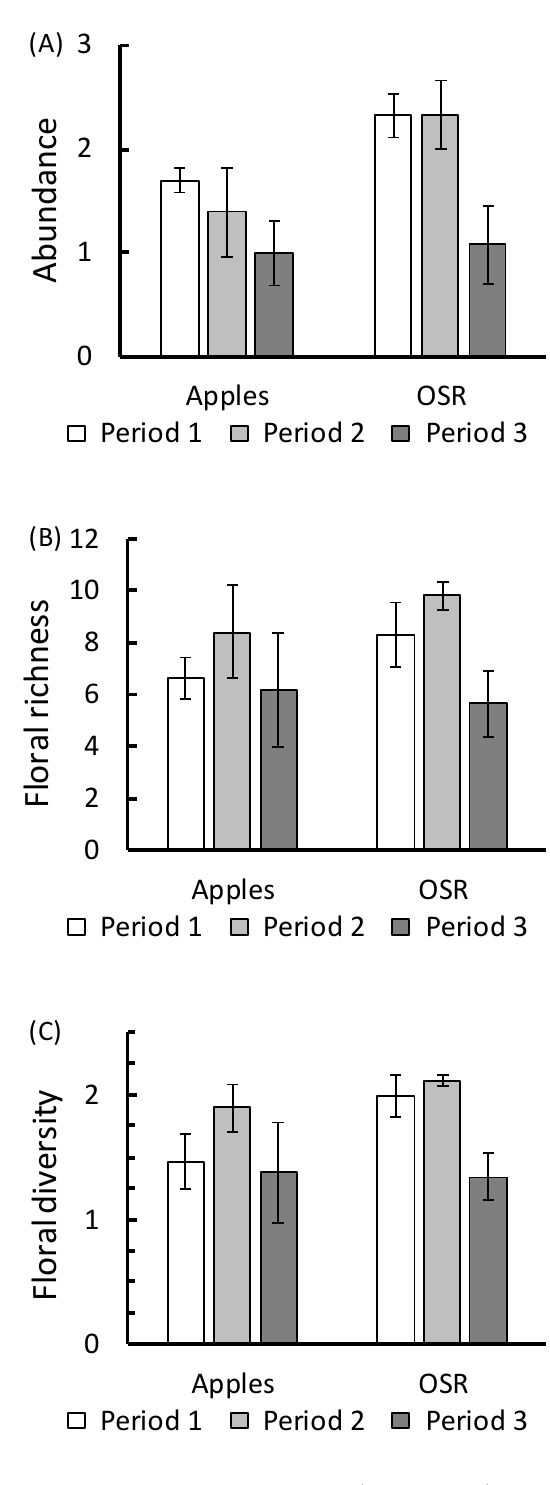
Figure 5. Abundance and diversity (mean ± SE) of entomophilous flowering plants in field boundaries during the flowering period (Period 1), 1-month after flowering (Period 2) and 3-months after flowering (Period 3) in OSR ( n = 6) and apples ( n = 5), where ( a ) median abundance score, ( b ) total species of species in flower, and ( c ) species diversity of flowering